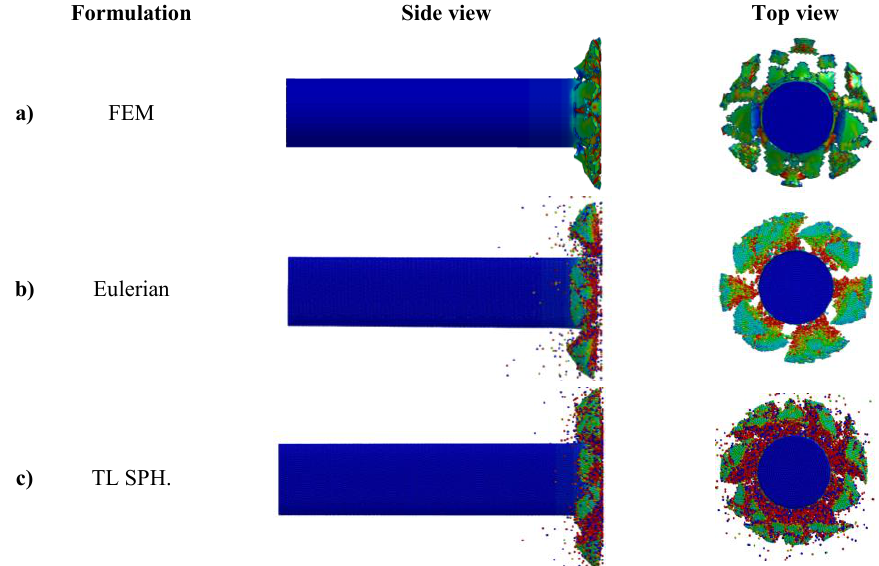
Fig. 6. Visual result of fragmentation obtained using CL fracture criterion. Impact velocity 97.5 m/s.